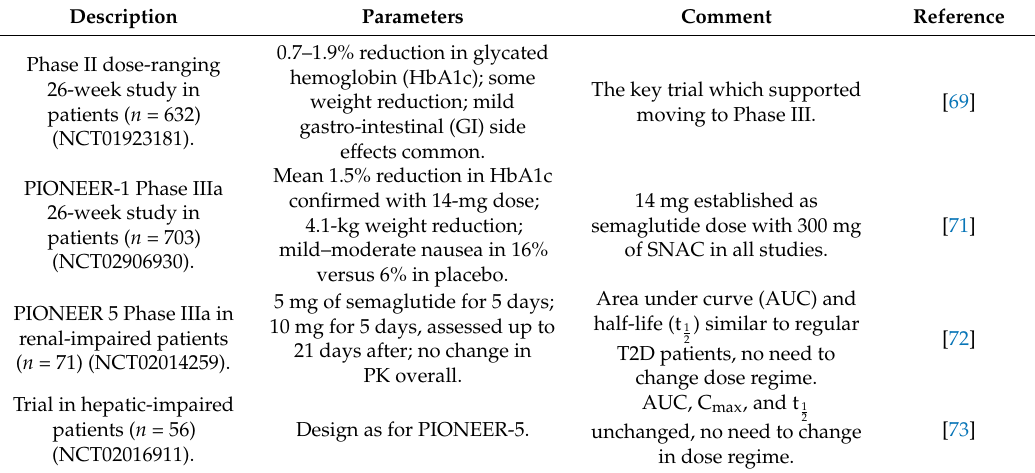
Table 3. Selected clinical trial data with an emphasis on peer-reviewed literature from the daily semaglutide/SNAC oral tablet formulation from Novo Nordisk in T2D